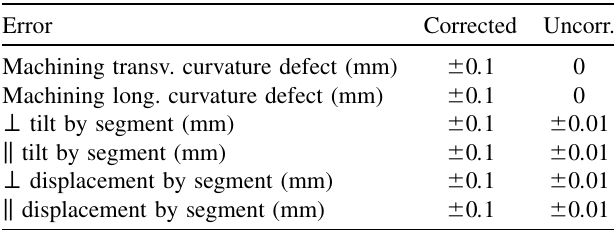
TABLE IX. The amplitudes of errors for the RFQ cavity. Error Corrected Uncorr.